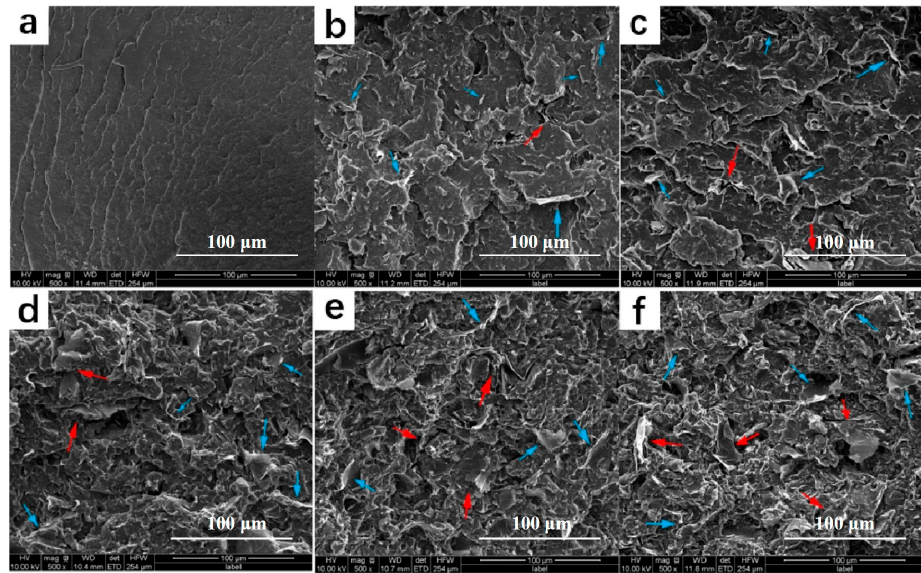
Figure 9. Scanning electron microscope image. ( a ) Pure PA12; ( b ) PA12/2 wt% GNPs; ( c ) PA12/4 Scanning electron microscope wt% GNPs; ( d ) PA12/6 wt% GNPs; ( e ) PA12/8 wt% GNPs; ( f ) PA12/10 wt% GNPs (reproduced with permission from Reference [64] , Copyright 2017 John Wiley and Sons).